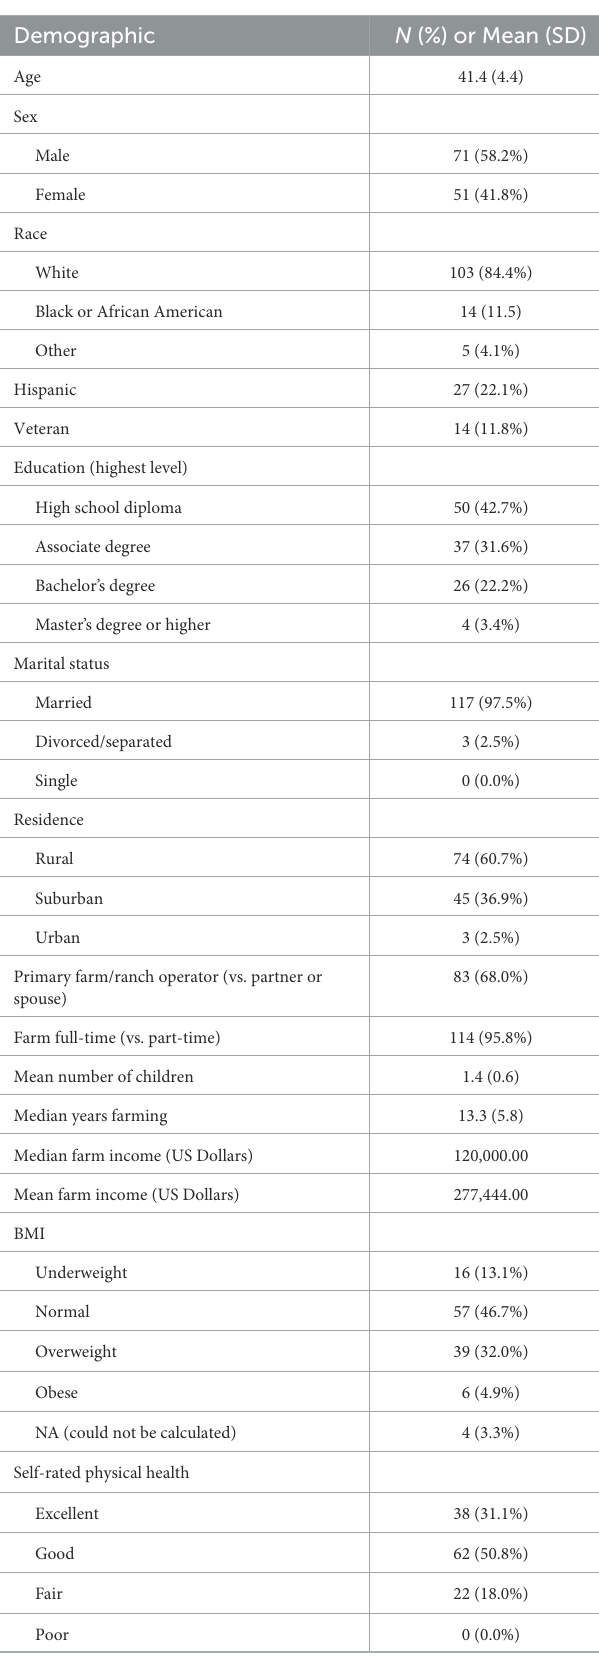
TABLE 1 Demographics and health characteristics of farm parents (P1) ( N =